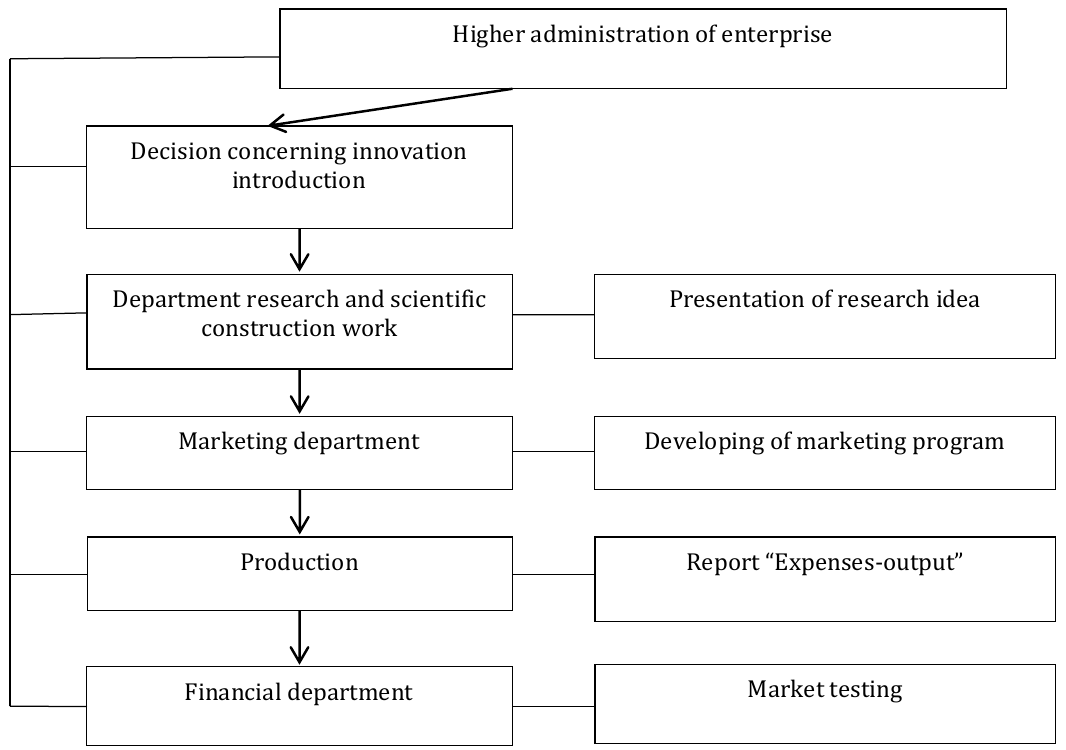
Figure 2: The successive form of organizing innovation activities at enterprises of agro- industrial